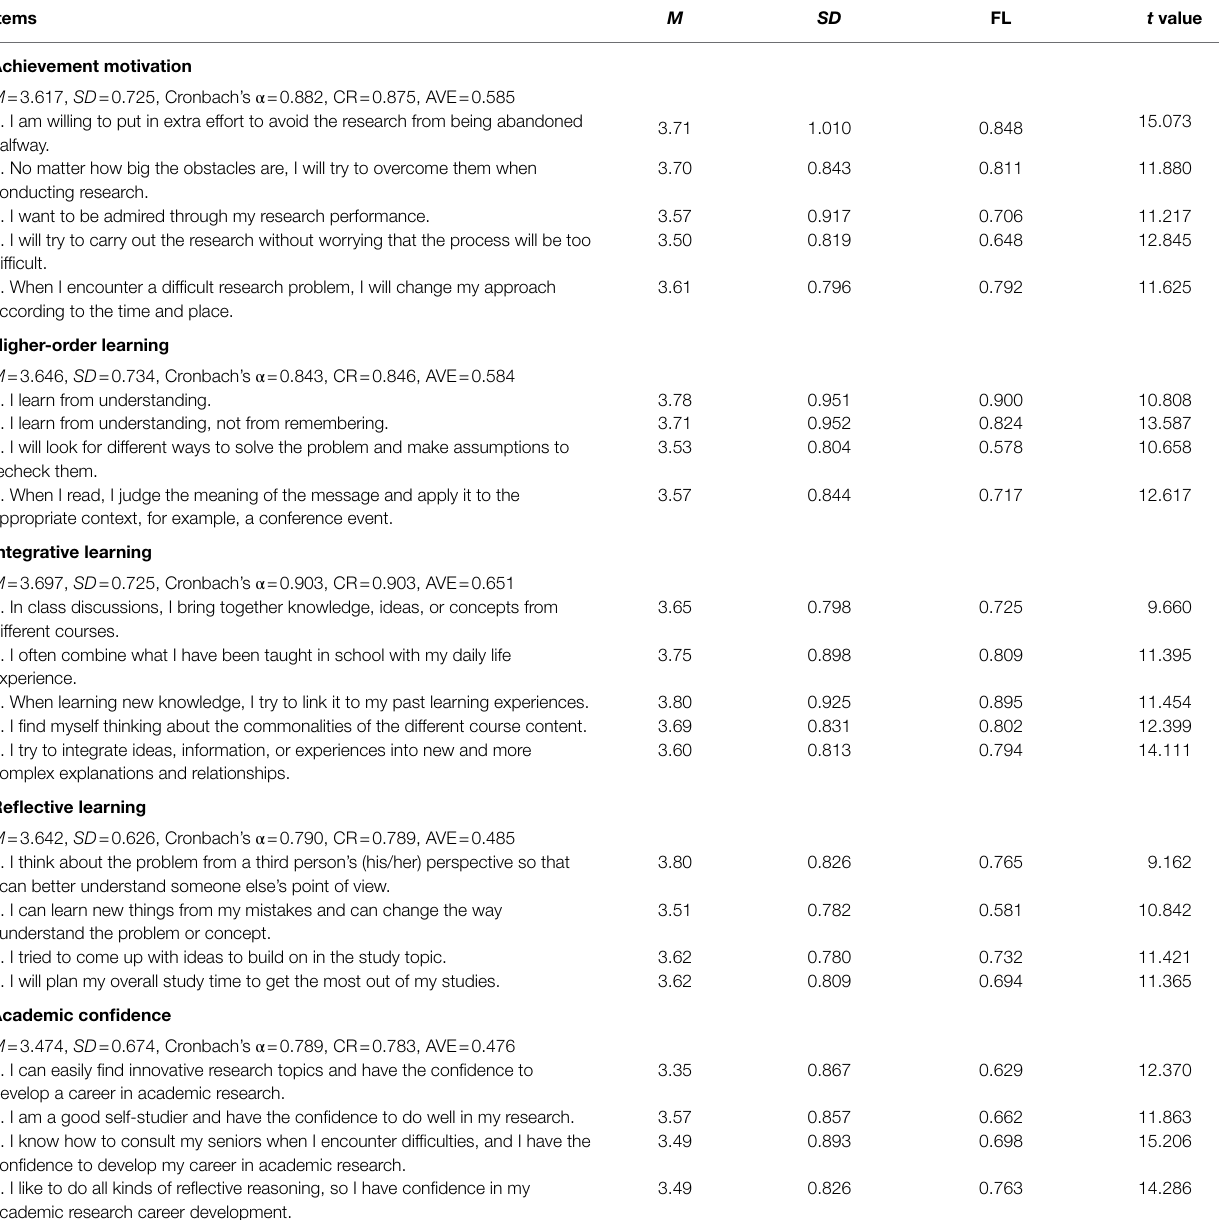
TABLE 3 | Reliability and validity